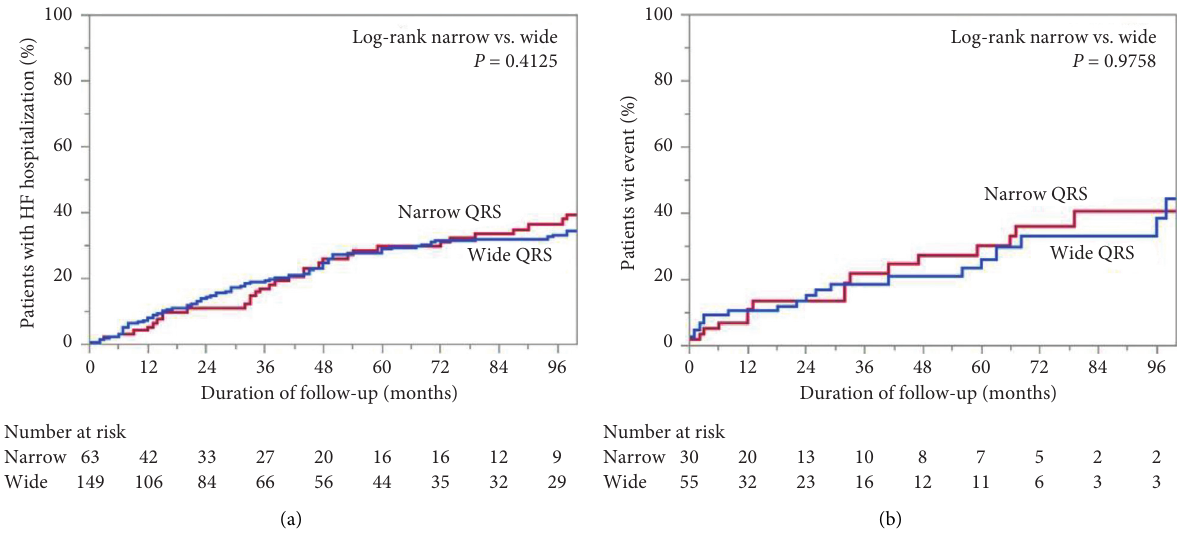
Figure 3: Heart failure hospitalization and cardiac death based on QRS duration. (a) HF hospitalization. (b) Cardiac death. Table 4: Predictors of all-mortality risk and univariate and multivariate Cox proportional hazards models.